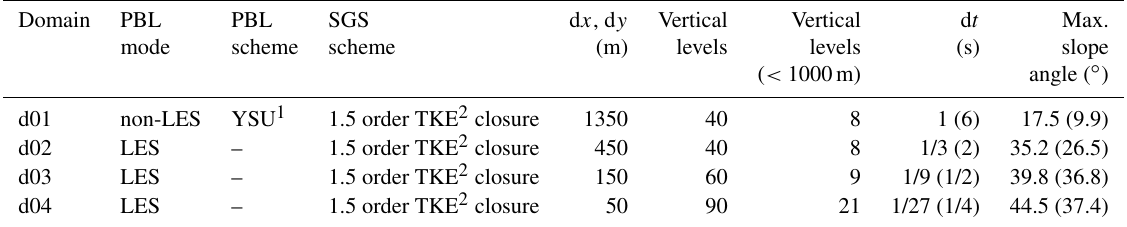
Table 1. Setup for the four nested domains (d01–d04) used in the WRF simulations. For the planetary boundary layer (PBL) the simulation mode is given, distinguishing between non-large eddy simulation (LES) and LES settings. For non-LES settings the PBL scheme is given. Additionally, the sub-grid-scale (SGS) turbulence parameterization is given for all four domains. d x and d y give the horizontal resolution. Vertical levels gives the number of vertical levels in the different domains. Vertical levels ( < 1000m) gives the number of vertical levels in the lowest 1000m of the atmosphere. The lowest 21 model levels for all four domains are given in Table S1. The time step (d t ) and the maximum slope angle are given for simulations with four (14) smoothing